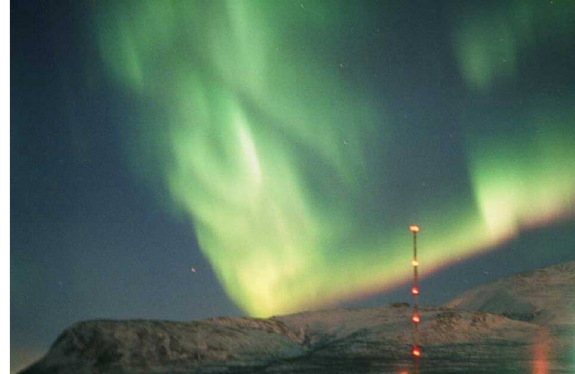
Fig. 11. Type A red aurora. Photo S. Chernouss.